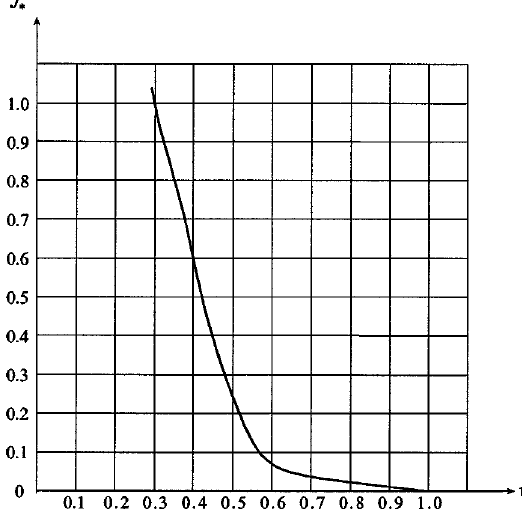
Fig. 3. Trade-off curve for a single-degree-of-freedom system sub- ject to a half-sine pulse disturbance. eration of the base, a: In other words, Fig. 3 shows the plot of the function J (cid:3) ( w (cid:3) ), where